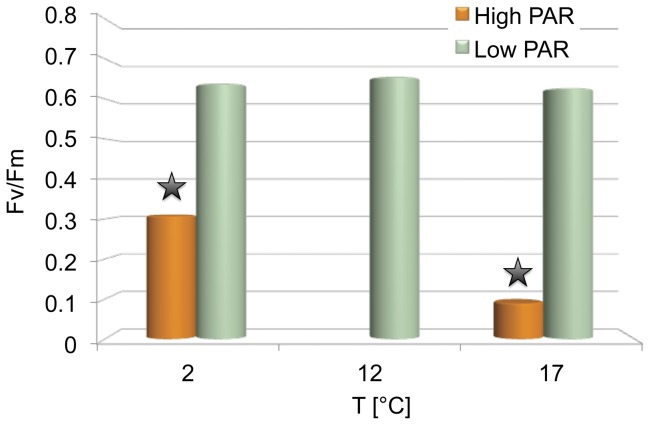
Efficiency of PS II (Fv/Fm) after 24 h exposure to different temperature and radiation conditions.The figure displays the maximum quantum yield of PS II in S. latissima after 24 h of exposure to different temperatures (2°C/17°C) and different light conditions (low/ high PAR). Standard deviations are represented by vertical bars (n = 5). Asterisk mark significant differences in efficiency of PS II (two-way ANOVA with repeated measurements, n = 5, p<0.01; post hoc Tukey test HSD, p<0.01).